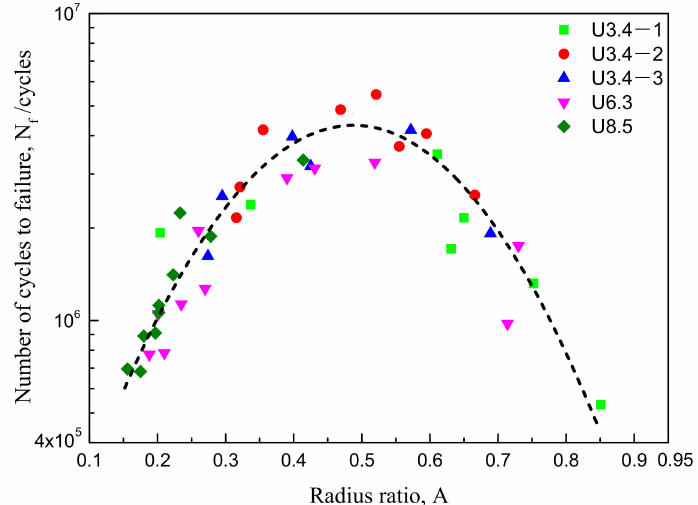
Figure 6. The relationship between N f and A for the axial fatigue test under the stress amplitude value of 870 MPa and different treatment conditions (to show the relationship between N f and A more clearly, the experimental data points are connected by dotted